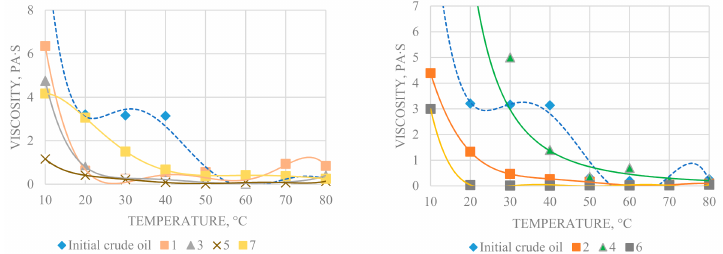
Figure 6. Structural viscosity of the original and converted oil during experiments 1–7.